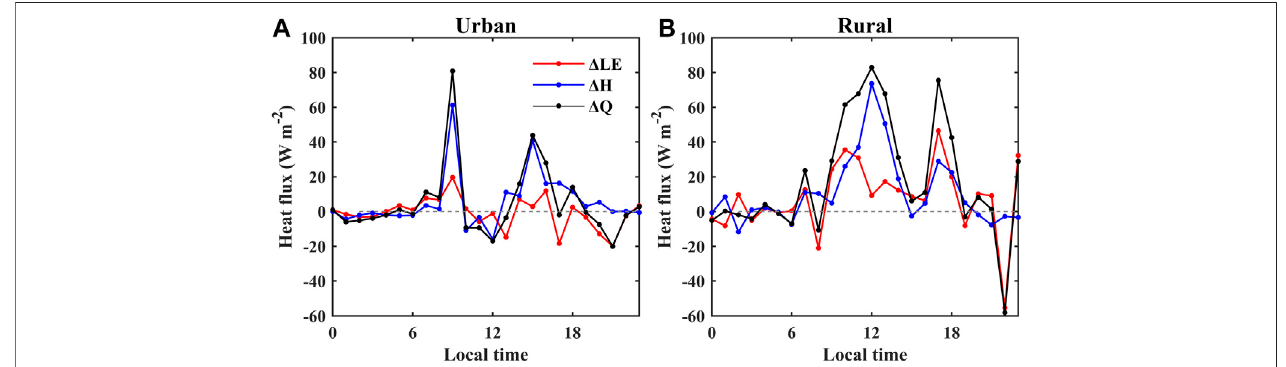
FIGURE 8 | The differences of heat fl ux at urban station (IAP) and rural station (MY) between HW days (2016.07.06 – 2016.07.08) and NHW days (2016.07.09 – 2016.07.11). LE: latent heat fl ux, H: sensible heat fl ux, to calculate Q as LE + H, Δ LE (cid:1) LE HWS -LE NHWS , Δ H (cid:1) H HWS -H NHWS , Δ Q (cid:1) Q HWS -Q NHWS .